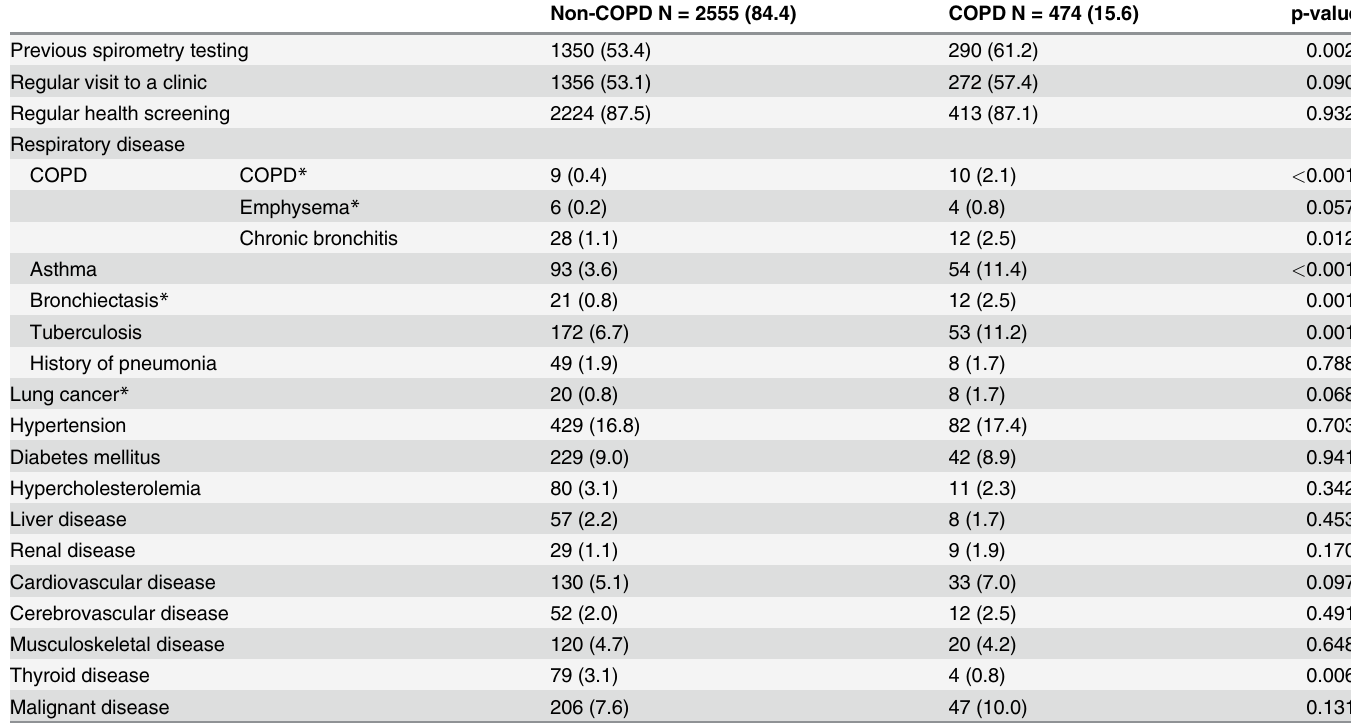
Table 2. Medical histories reported in the self-administered